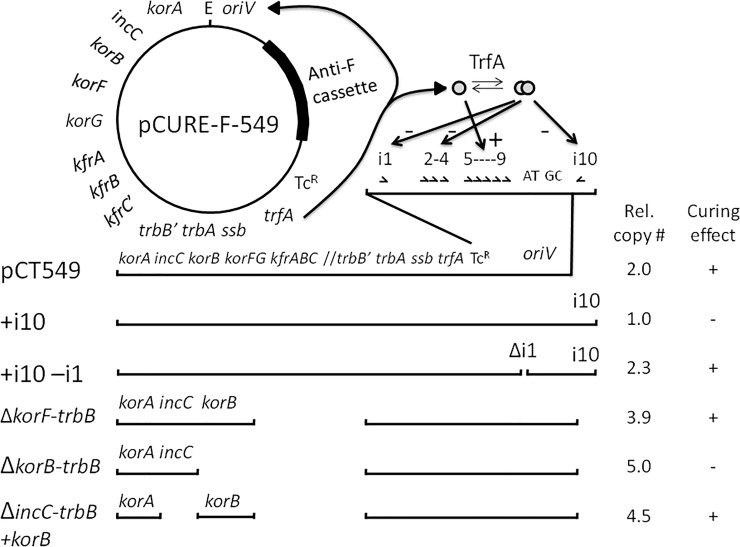
Mini-RK2 plasmids with the anti-F cassette and ability to displace F’prolac.Plasmid pCT549 consists of two segments from RK2: oriV to trbB’ and korA to kfrC’ (apostrophe indicates a truncated gene). TrfA acts at oriV: monomers act positively through iterons 5–9 and dimers act negatively through all the iterons. Due to its construction oriV of pCT549 excluded iteron 10 (i10) and with addition of the anti-F cassette efficient curing was seen. A derivative with iterons 1 to 10 gave a lower relative copy number (data and statistics in S2 Fig, S1 Raw Images and S1 Table) and efficient curing was lost. Deletion of i1 restored efficient curing and relative copy number rose approximately 2-fold. Deleting up to korB had no effect but deleting past it destroyed curing. Reinserting korB restored efficient curing.